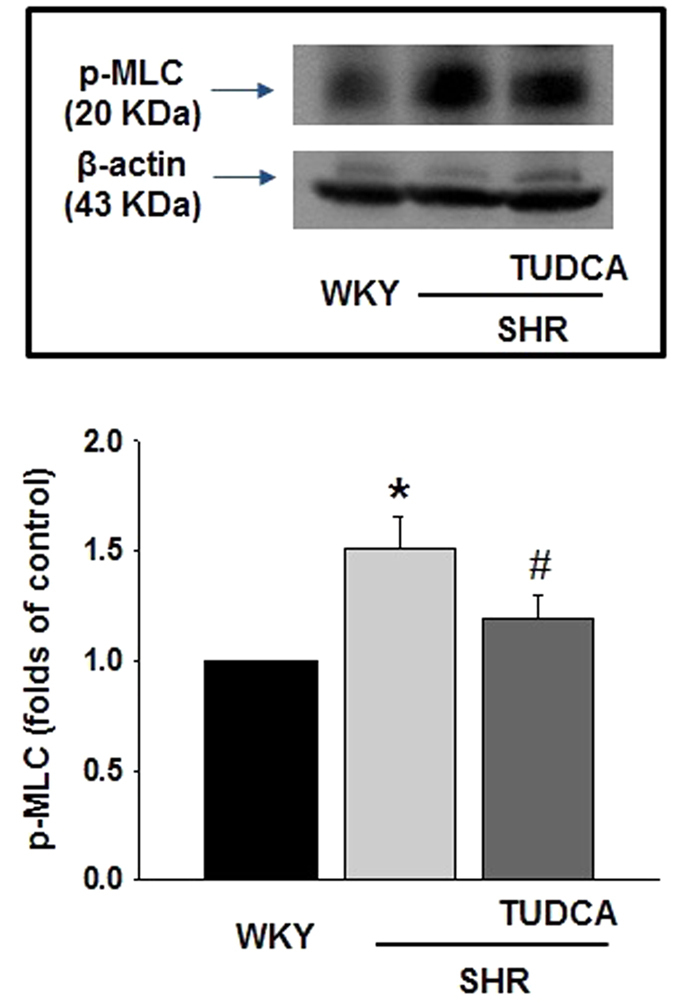
Effects of TUDCA on the phosphorylation of MLC20 at Ser19.The representative western blot analysis and quantitative data for phosphorylation of MLC20. (n = 4) *p < 0.05 for WKYs vs. SHRs, #p < 0.05 for SHRs vs. SHRs with TUDCA.